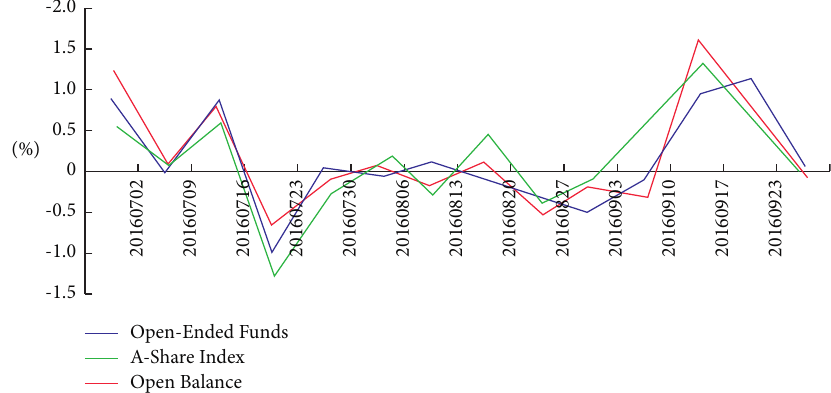
Figure 4: Average fund NAV growth and A-share market returns by week.